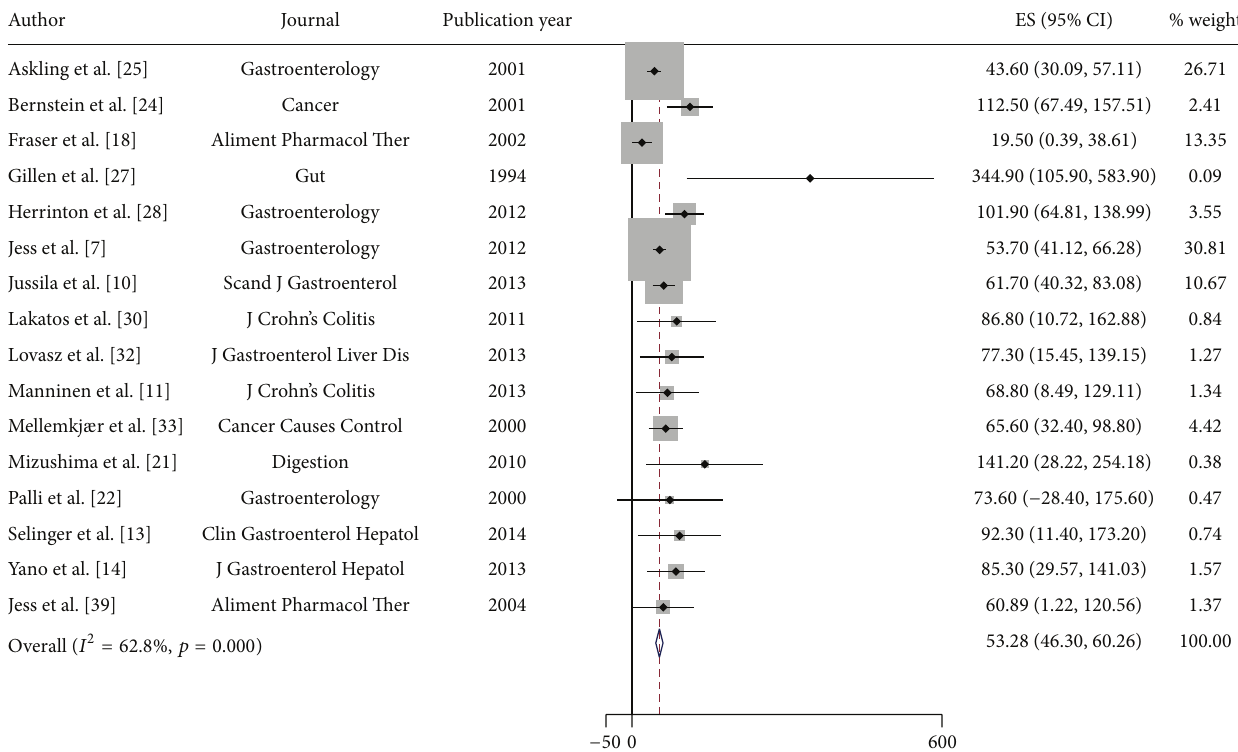
Figure 2: Incidence of colorectal cancer (CRC) in patients with Crohn’s Disease (CD). Each incidence estimate is presented followed by the 95% confidence intervals (CIs). Each square in the plot indicates the point estimate of the incidence. The diamond represents the summary incidence from the pooled studies. Error bars depict the 95% CIs.